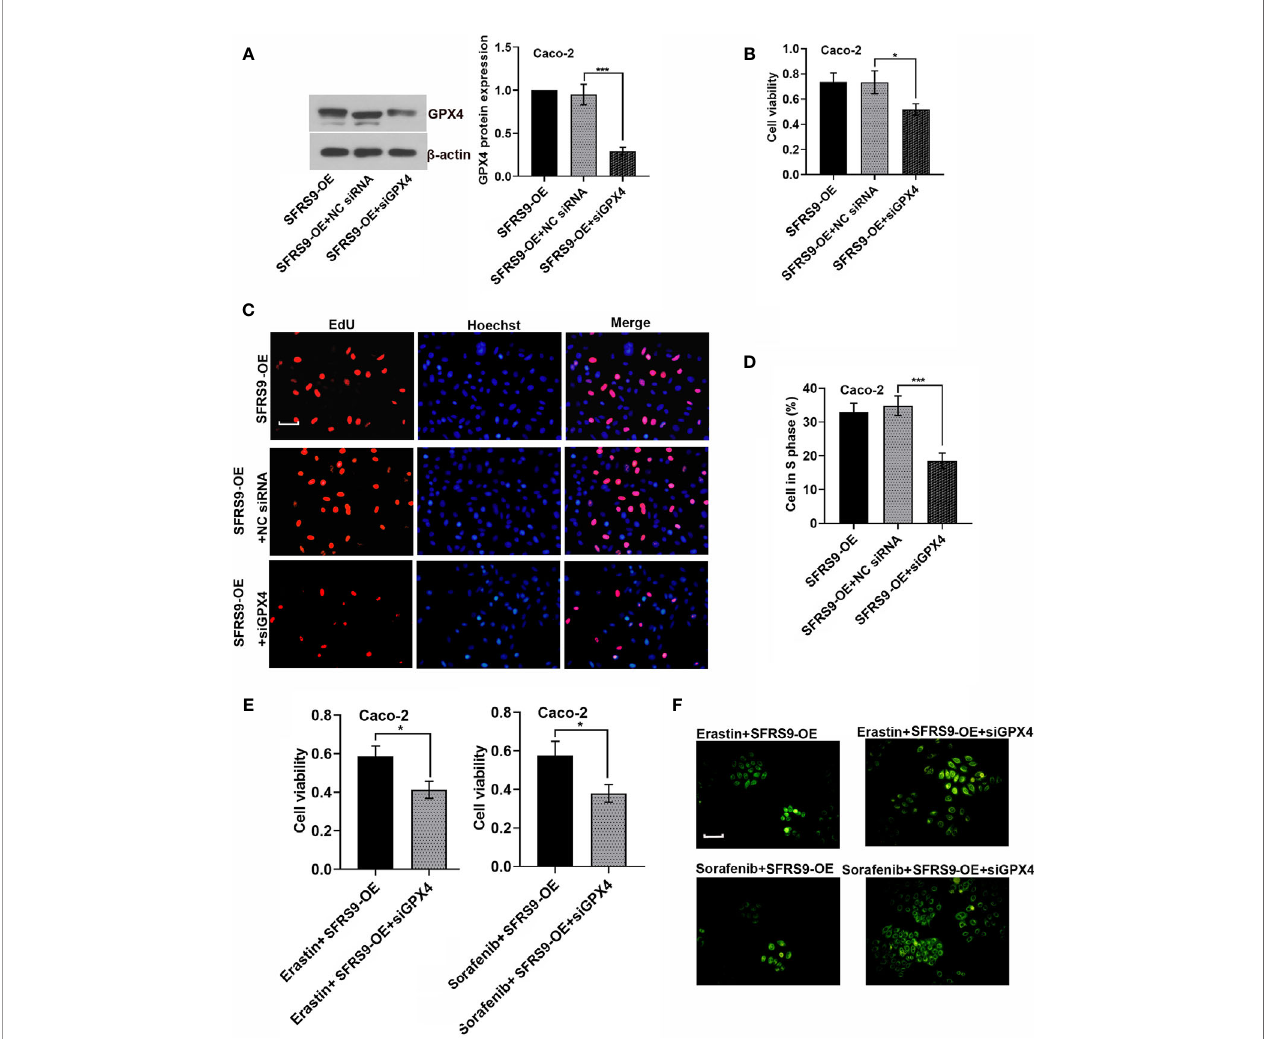
FIGURE 7 | SFRS9 affected the viability and ferroptosis of CRC cells through regulating GPX4. (A) The protein levels of GPX4 in Caco-2 cells co-transfected with SFRS9-OE vector and siGPX4. (B) The viability of Caco-2 cells co-transfected with SFRS9-OE vector and siGPX4 was measured using the CCK-8 assay. (C, D) Representative images and data analysis of EdU staining of Caco-2 cells co-transfected with SFRS9-OE vector and siGPX4. Scale bars: 50 m m. (E) The viability of Caco-2 cells co-transfected with SFRS9-OE vector and siGPX4 in presence or absence ferroptosis inducer erastin or sorafenib. (F) C11-BODIPY staining of Caco-2 cells following transfection with SFRS9-OE vector and siGPX4 in presence or absence ferroptosis inducer erastin or sorafenib. Scale bars: 100 m m. Values are mean ± SD. *p < 0.05, ***p <